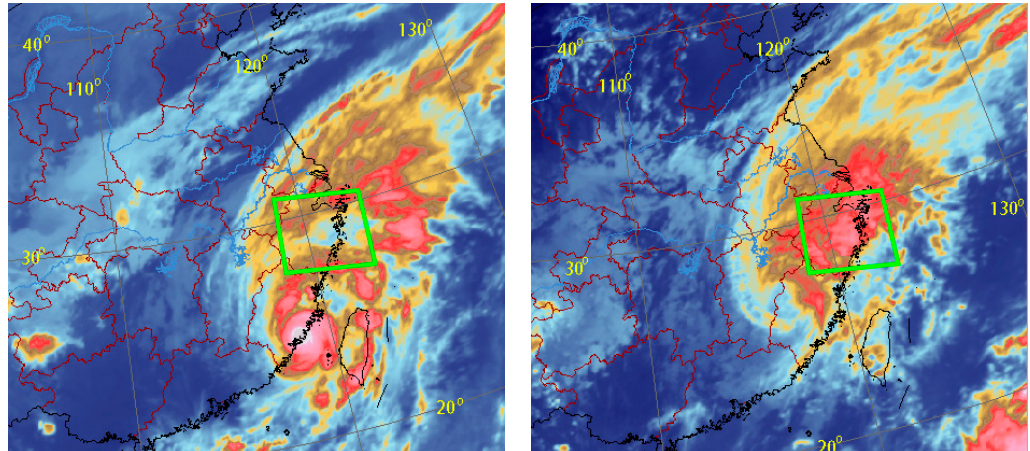
Figure 12. MERANTI satellite images from China FY2E-IR1 satellite at 03:30 ( right panel) and at 14:30 ( left panel), respectively, on 15 September. Research areas are highlighted by green boxes (FY2E is one satellite of the Fengyun-2 constellation, IR1 indicates infrared 1 channel).